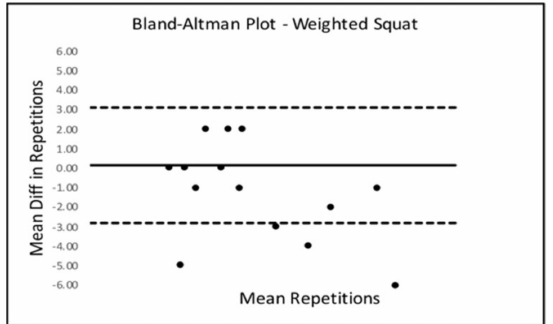
Figure 5. Bland–Altman Plot—Squat.